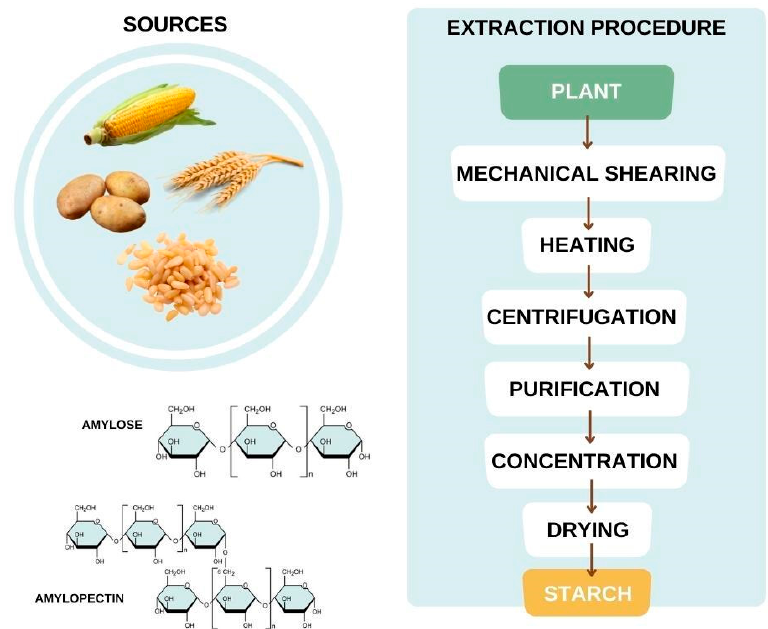
Figure 11. Starch: Sources, chemical composition, and extraction procedure (Adapted with permis- sion from Ref. [141] . Copyright 2016, Elsevier).